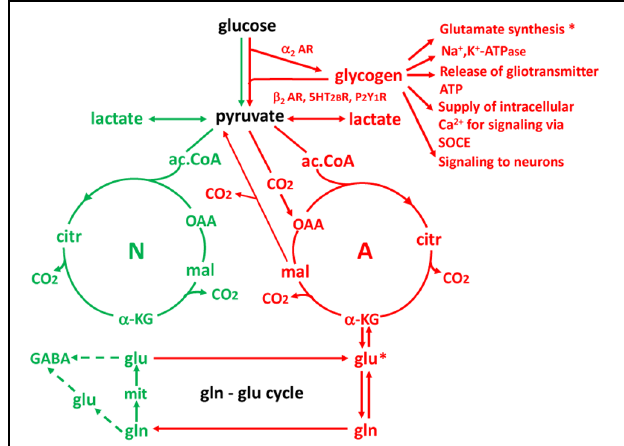
FIGURE 12 | Cartoon showing key features of glucose metabolism in neurons (N and green) and astrocytes (A and red) and interactions between the two cell types. Three reactions of importance in the present review are astrocyte-specific: (1) glycogenolysis (and thus its stimulation by noradrenergic, serotonergic and purinergic subtype-specific agonists); (2) formation of the tricarboxylic acid (TCA) cycle intermediate oxaloacetate (OAA) by condensation of pyruvate with CO 2 (pyruvate carboxylation); and (3) formation of glutamine from glutamate by glutamine synthetase. Reaction (1) is important for the transmitter actions on memory and for glutamate synthesis documented in this review, and for partial alleviation by β 2 -adrenergic activity of DAB-impaired memory resulting from Na,K-ATPase inhibition and inhibition of release of gliotransmitter ATP and of SOCE by DAB referred to. It is also important for release of lactate acting on neurons. Reaction (2) is essential for creation of a new molecule of a TCA cycle constituent OAA, allowing another molecule of a TCA cycle constituent, α -KG to leave the cycle and form glutamate. *Indicates the importance of glycogenolysis for glutamate synthesis and glutamate synthesis from α -KG. And reaction (3) is a crucial step in supplying neurons with both newly synthesized and previously released glutamate. A fourth astrocyte-specific reaction is conversion of malate to pyruvate after its exit from the TCA cycle. This reaction allows metabolic degradation of accumulated glutamate but is not discussed in the review. The Figure should not give the impression that one half of brain energy metabolism is neuronal and one half astrocytic. Astrocytes account for a smaller fraction of the volume and therefore only for about one quarter of total glucose metabolism in gray matter (reviewed by Hertz, 2011), and other cell types like microglia also contribute to total energy